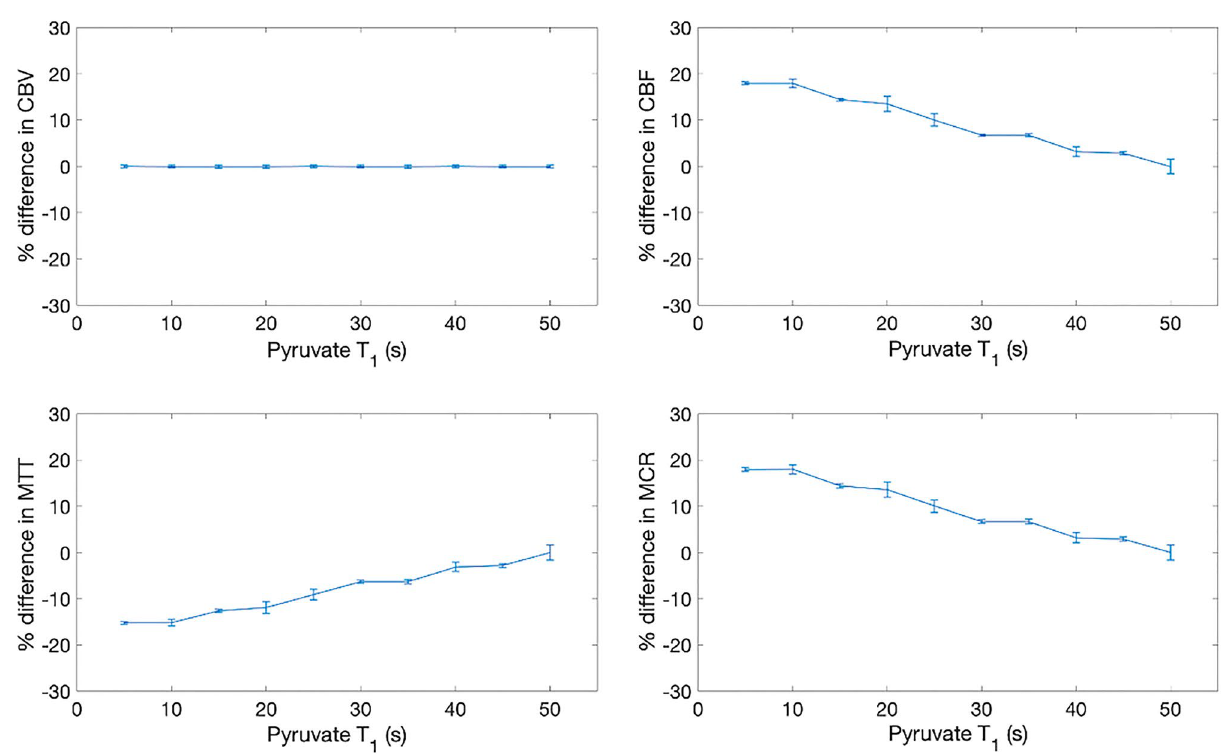
Figure 6. Simulation results demonstrating model variation with pyruvate T1 across all parameters. kPL, flip angle, SNR, and B1 error are assumed to be 0, 10°, 100, and 1,